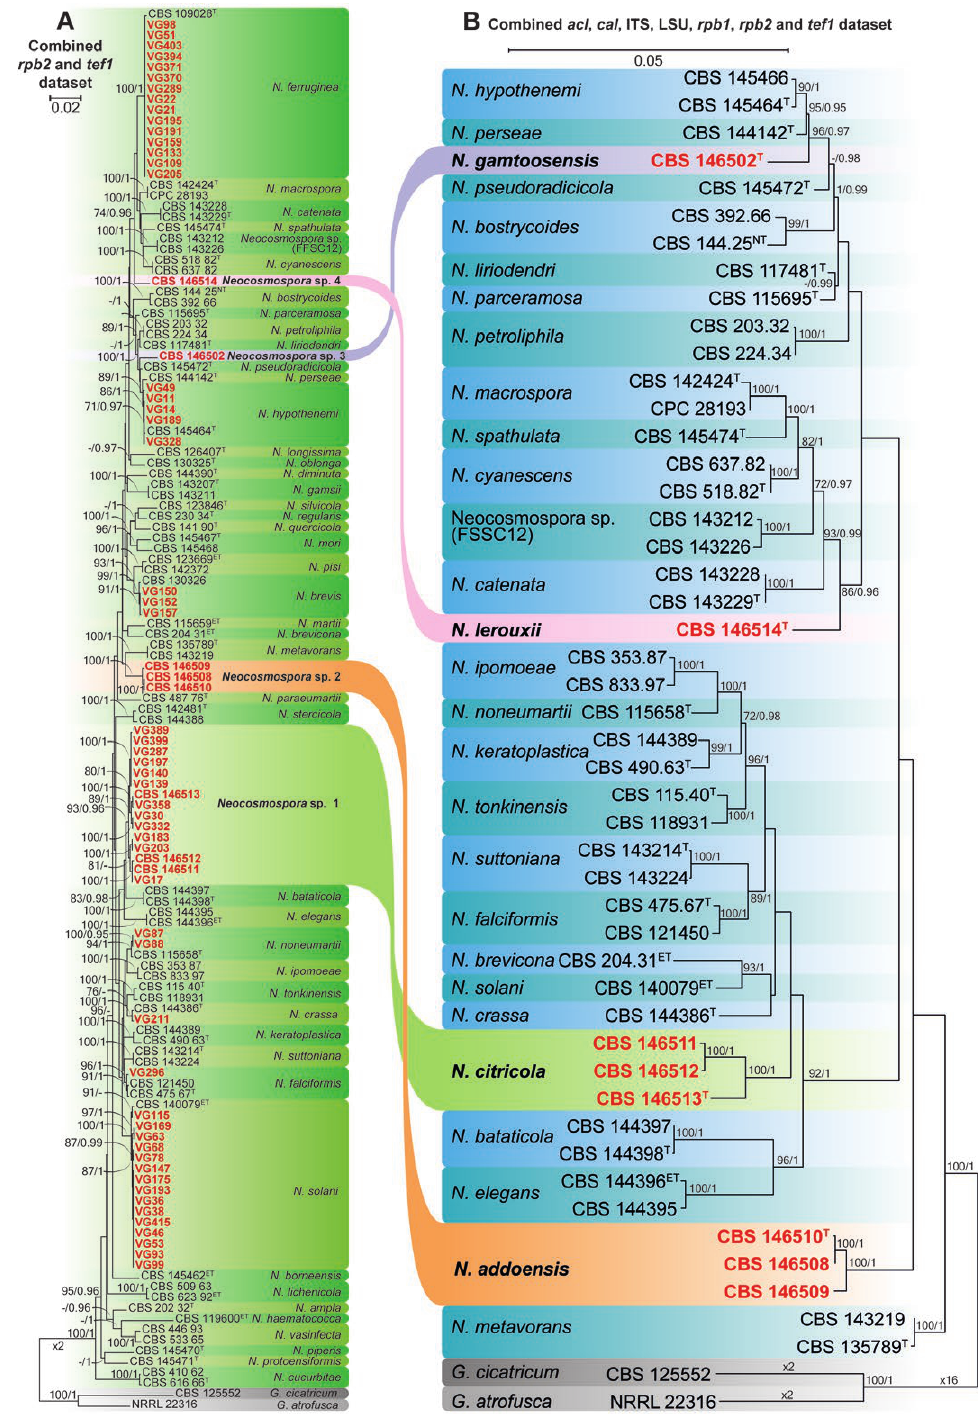
Figure 3. Maximum-likelihood (ML) phylograms obtained from combined rpb2 and tef1 (A) and acl , cal ITS, LSU, rpb1 , rpb2 and tef1 (B) sequences, of 62 isolates of Neocosmospora spp. from South African Citrus (shown in red), and representative and ex-type isolates of Neo- cosmospora . Names of new species described here are shown in bold font . Numbers on the nodes are ML bootstrap values greater than 70% followed by Bayesian posterior probability values greater than 0.95. Branch lengths are proportional to distance. Ex-type, ex-epitype and ex-neotype strains are indicated, respectively, with T , ET and NT . The trees are rooted to Geejayesia atrofusca (NRRL 22316 and G. cicatricum (CBS